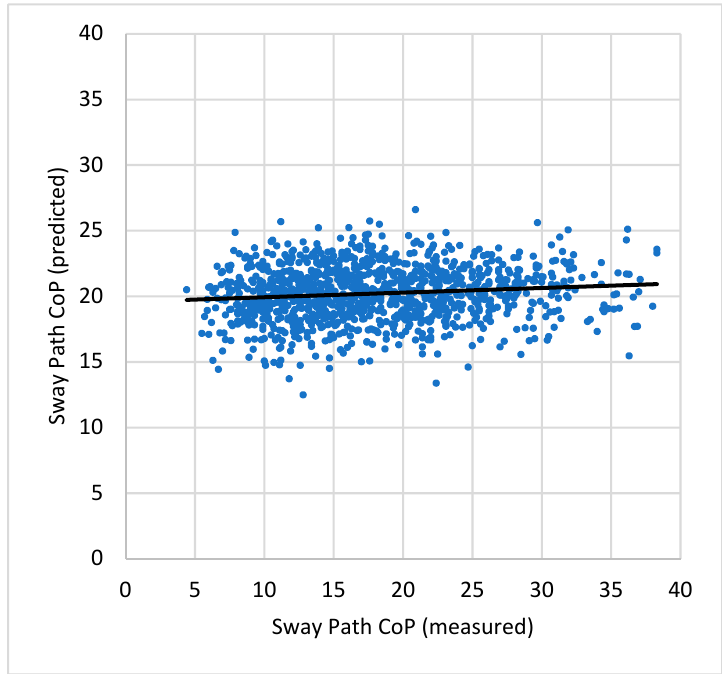
Figure 2. Scatterplot of the predicted (from Table 3 values) over the measured Sway Path CoP. The black line is a linear fit of the plotted points, just to help in the visualization. Most of the fits, and most of the fitting coefficients, have statistically significant values.